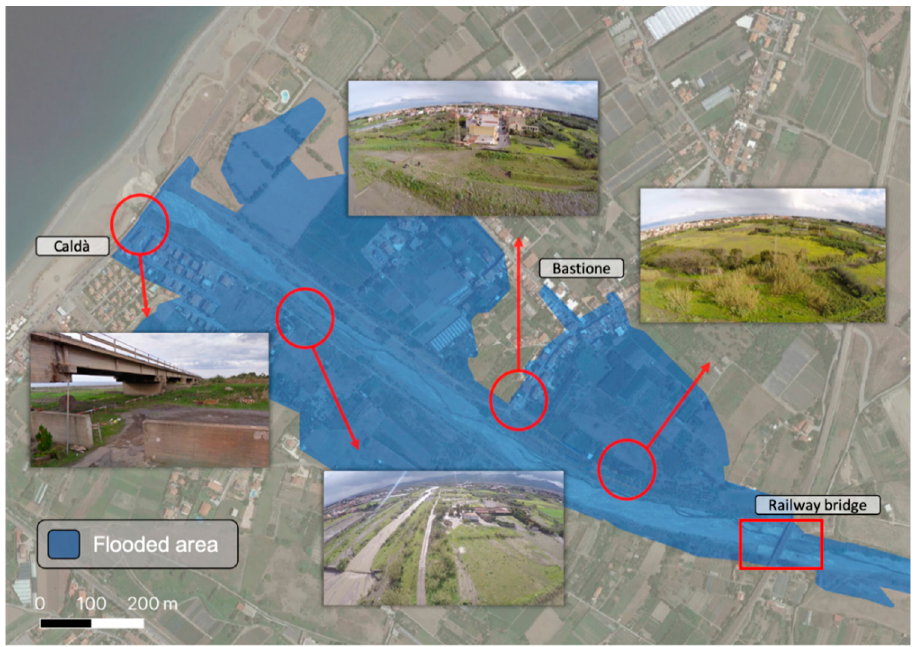
Figure 2. Historical inundated area during the event of October 2015, with evidence of the flooding source points (red circles).